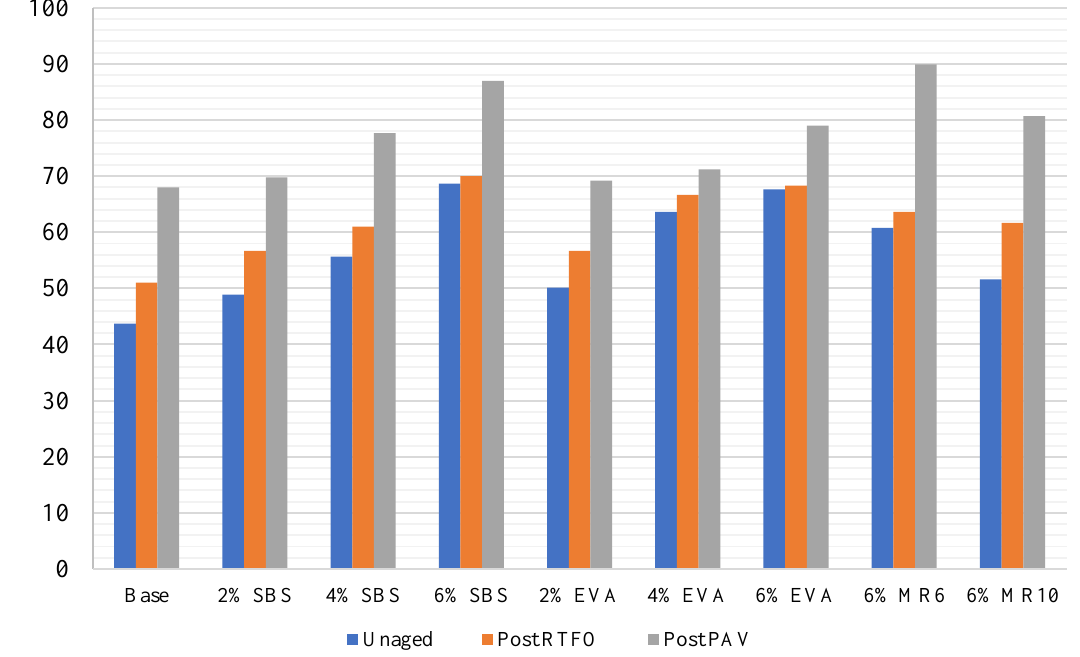
Figure 2. Binder average softening point before and after ageing.